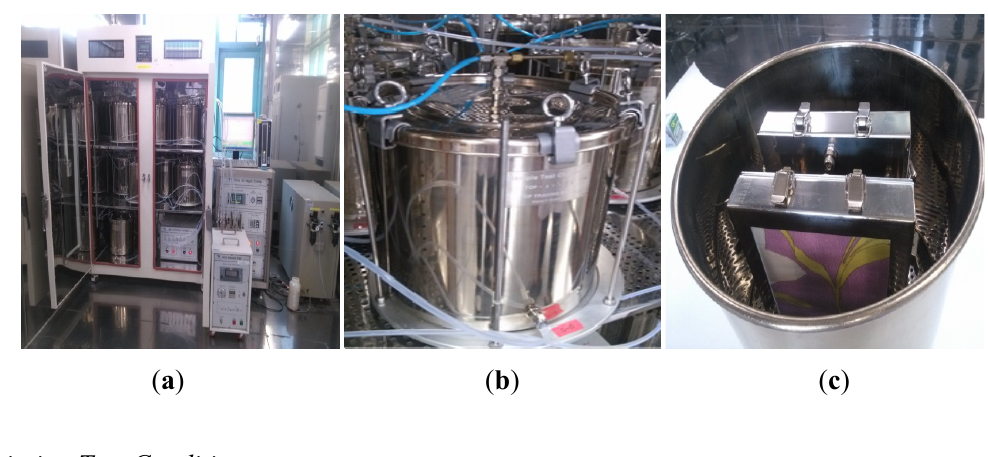
Figure 2. Photograph of the 20 L small emission chamber used in this study.